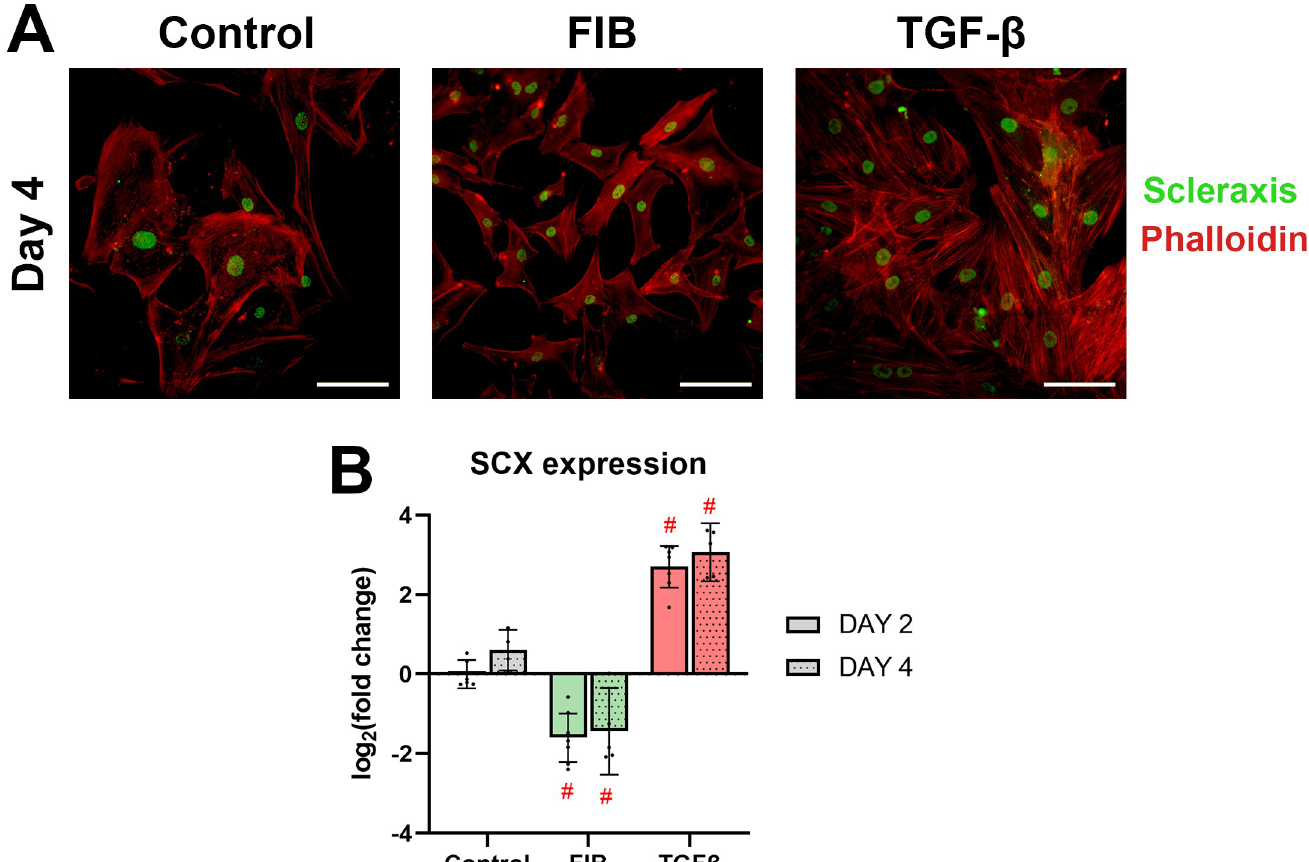
Fig 11. Scleraxis, potential myofibroblast marker, is upregulated by TGF- β . (A) shows representative images of hVICs stained for scleraxis (green) and phalloidin (red) on day 4. Representative images of day 2 did not appreciably differ from day 4, and are available in the supplementary materials (S3). Scale bars represent 100 μ m. (B) shows RT-qPCR results of SCX (scleraxis) gene expression. In a mixed effects model, experimental groups were compared to control at each time point. � p < 0.05, #p < 0.01, dots represent biological replicates (n = 7 on day 2, n = 5 on day 4), error bars represent 95% CI.